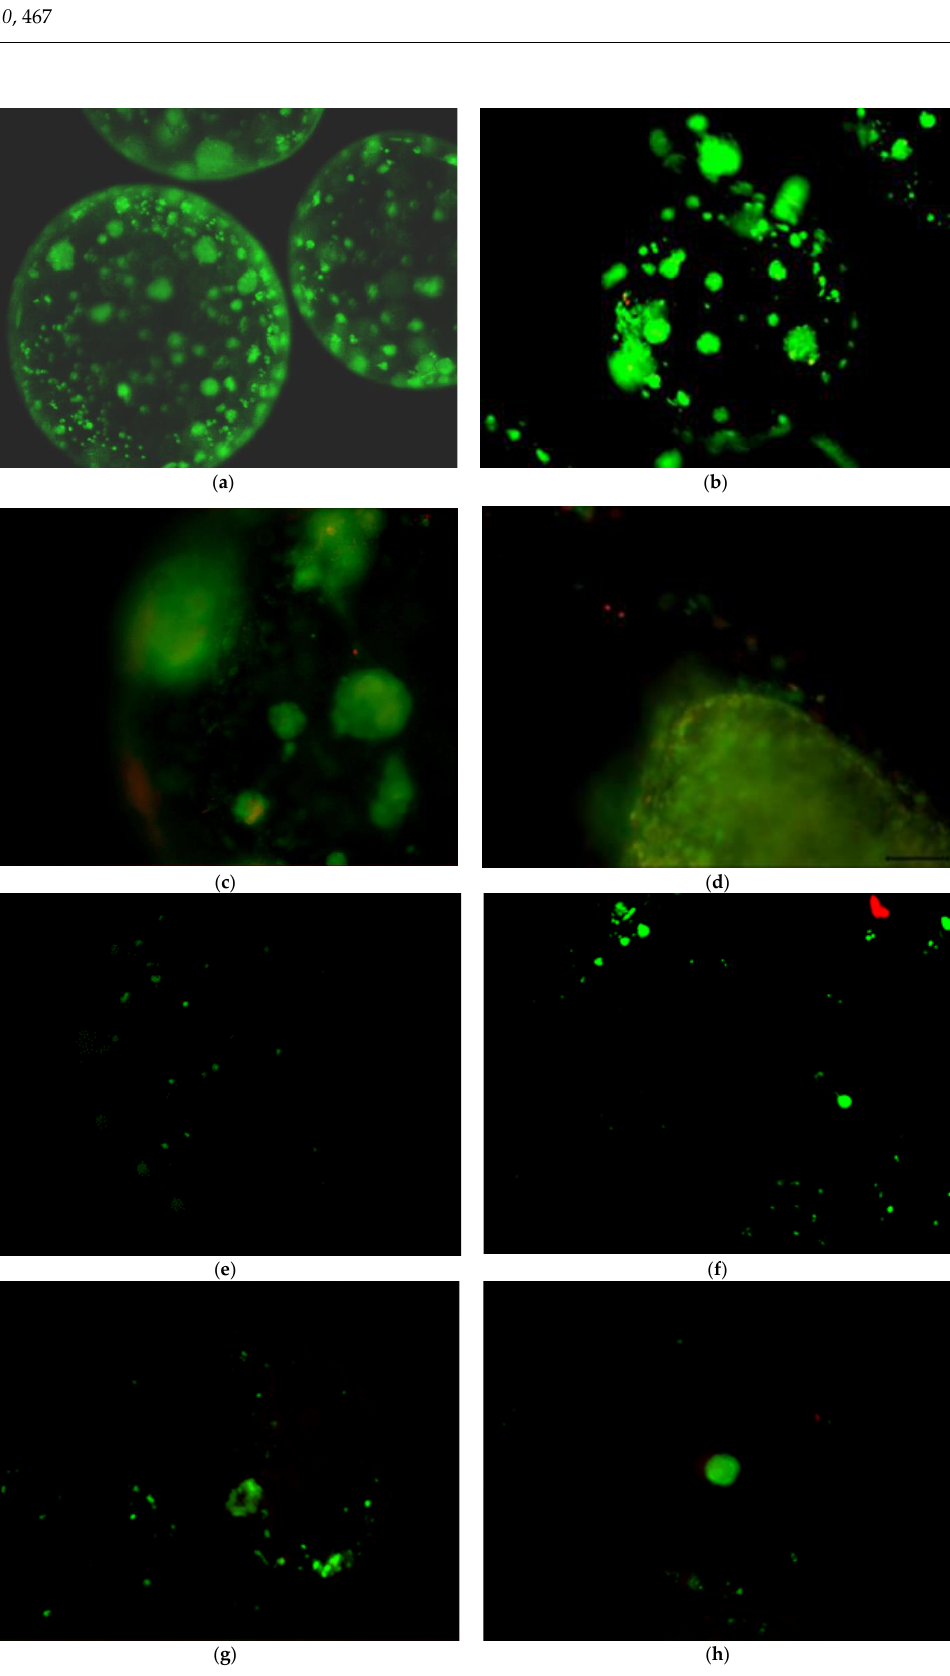
Figure 8. Calcein AM/ethidium homodimer (live/dead) fluorescence images of the 28-day chondro- cyte and bMSC encapsulated cultures. ( a ) Chondrocytes day 7; ( b ) chondrocytes day 14; ( c ) chondrocytes day 21; ( d ) chondrocytes day 28; ( e ) bMSC day 7; ( f ) bMSC day 14; ( g ) bMSC day 21; ( h ) bMSC day 28. All images were captured with a ×